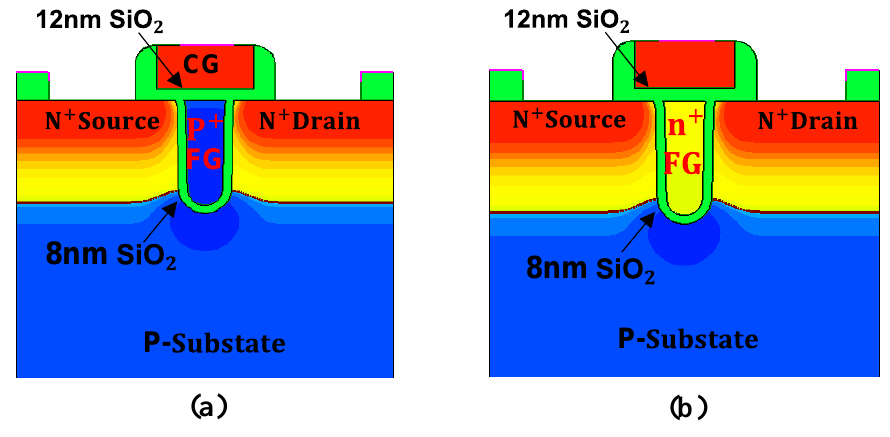
Figure 2. The device structure of UFGM with SiO 2 based ( a ) p + FG and ( b ) n + FG.